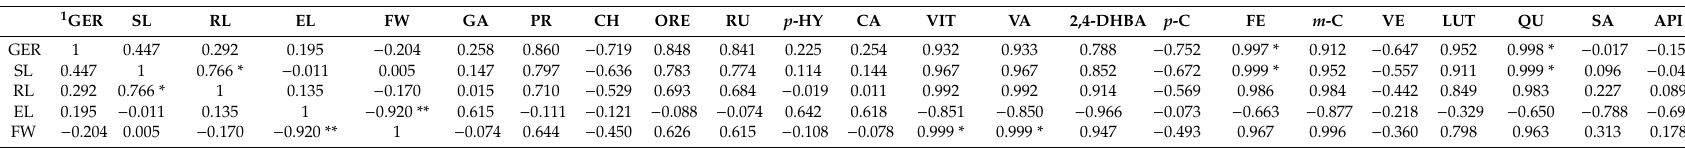
Table 5. Pearson correlation coe ffi cients (r) between seed germination, shoot length, root length, electrolyte leakage, fresh weight, and phenolic compounds of M. sacchariflorus